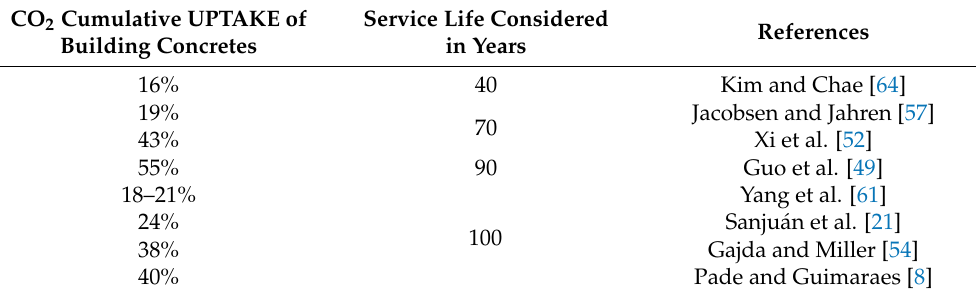
Table 2. Cumulative CO 2 uptake of cementitious’ products by previous